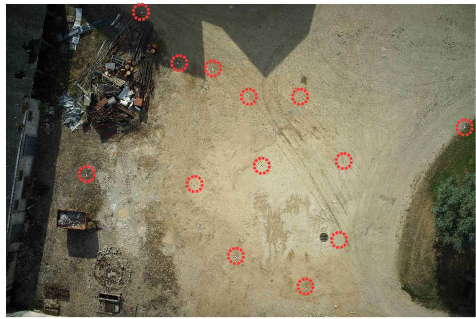
Figure 2: Scene containing GCPs used for lever-arm calibration